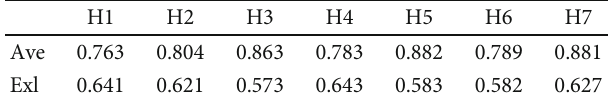
Table 1: Homework average scores and the excellent proportion.